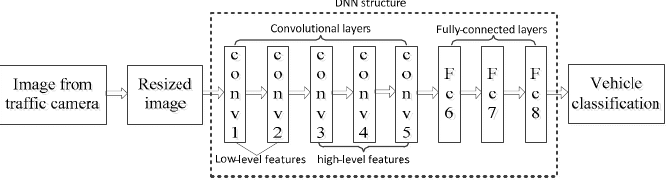
Figure 4. Structure and function of deep neuron network (DNN) (Alexnet model).